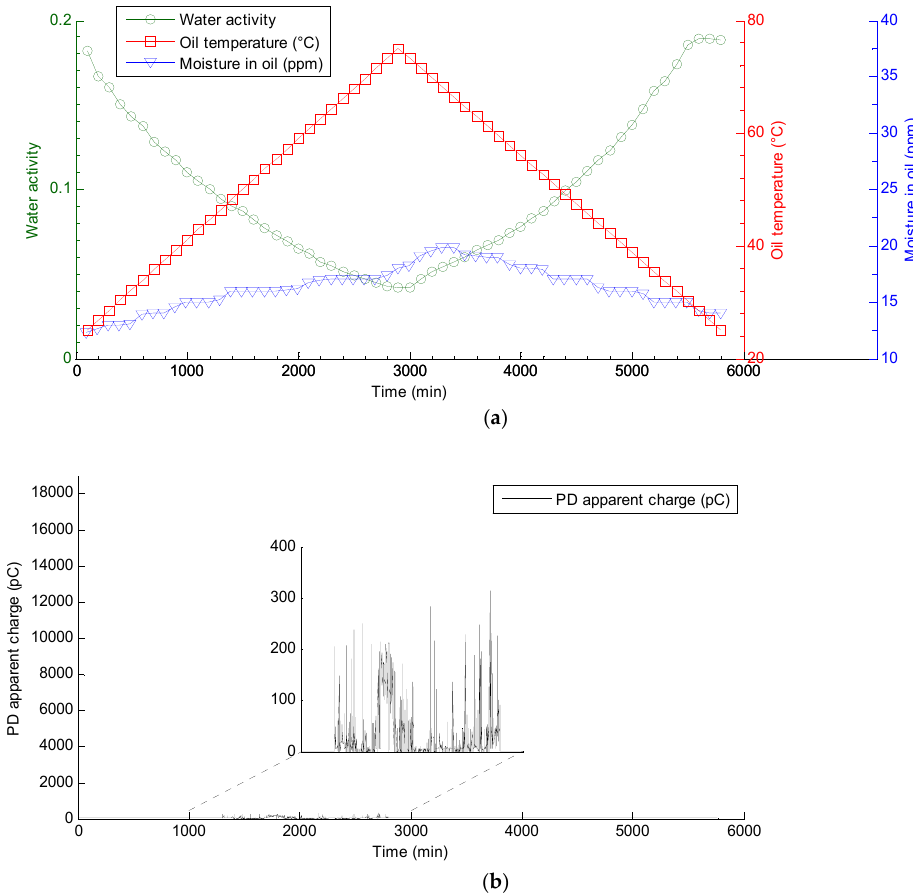
Figure 10. Typical experimental results obtained for an insulation sample with a moisture content of 1.6%: ( a ) water activity, temperature and moisture content of oil; and ( b ) PD apparent charge. Samples with the highest moisture content (5.7%) were investigated during the last stage of the experiment. Compared to samples with a 1.6% and 2.5% moisture content, the first PD pulses were